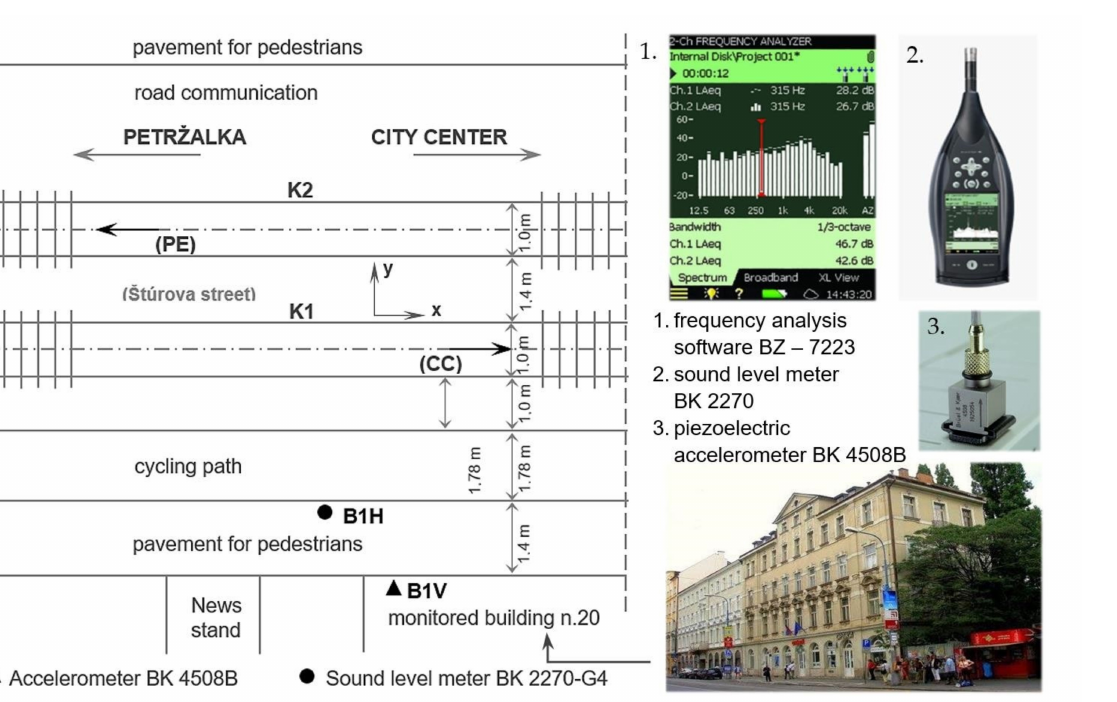
Figure 5. Location of measured points B1H (B1V) used devices and view of the monitored building—Št ú r